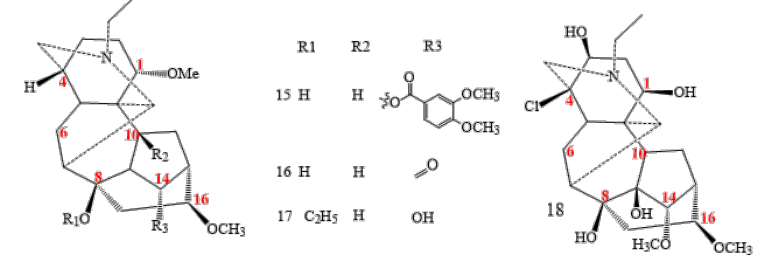
Figure 2. C 18 -lappaconitine DAs.